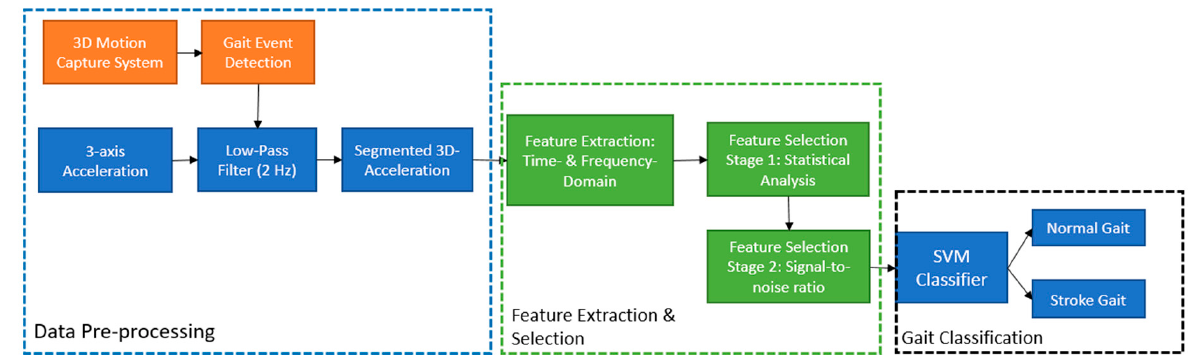
Figure 2. Diagram of classification method from data pre-processing, feature extraction and gait classification with Support Vector Machine (SVM) classifier.